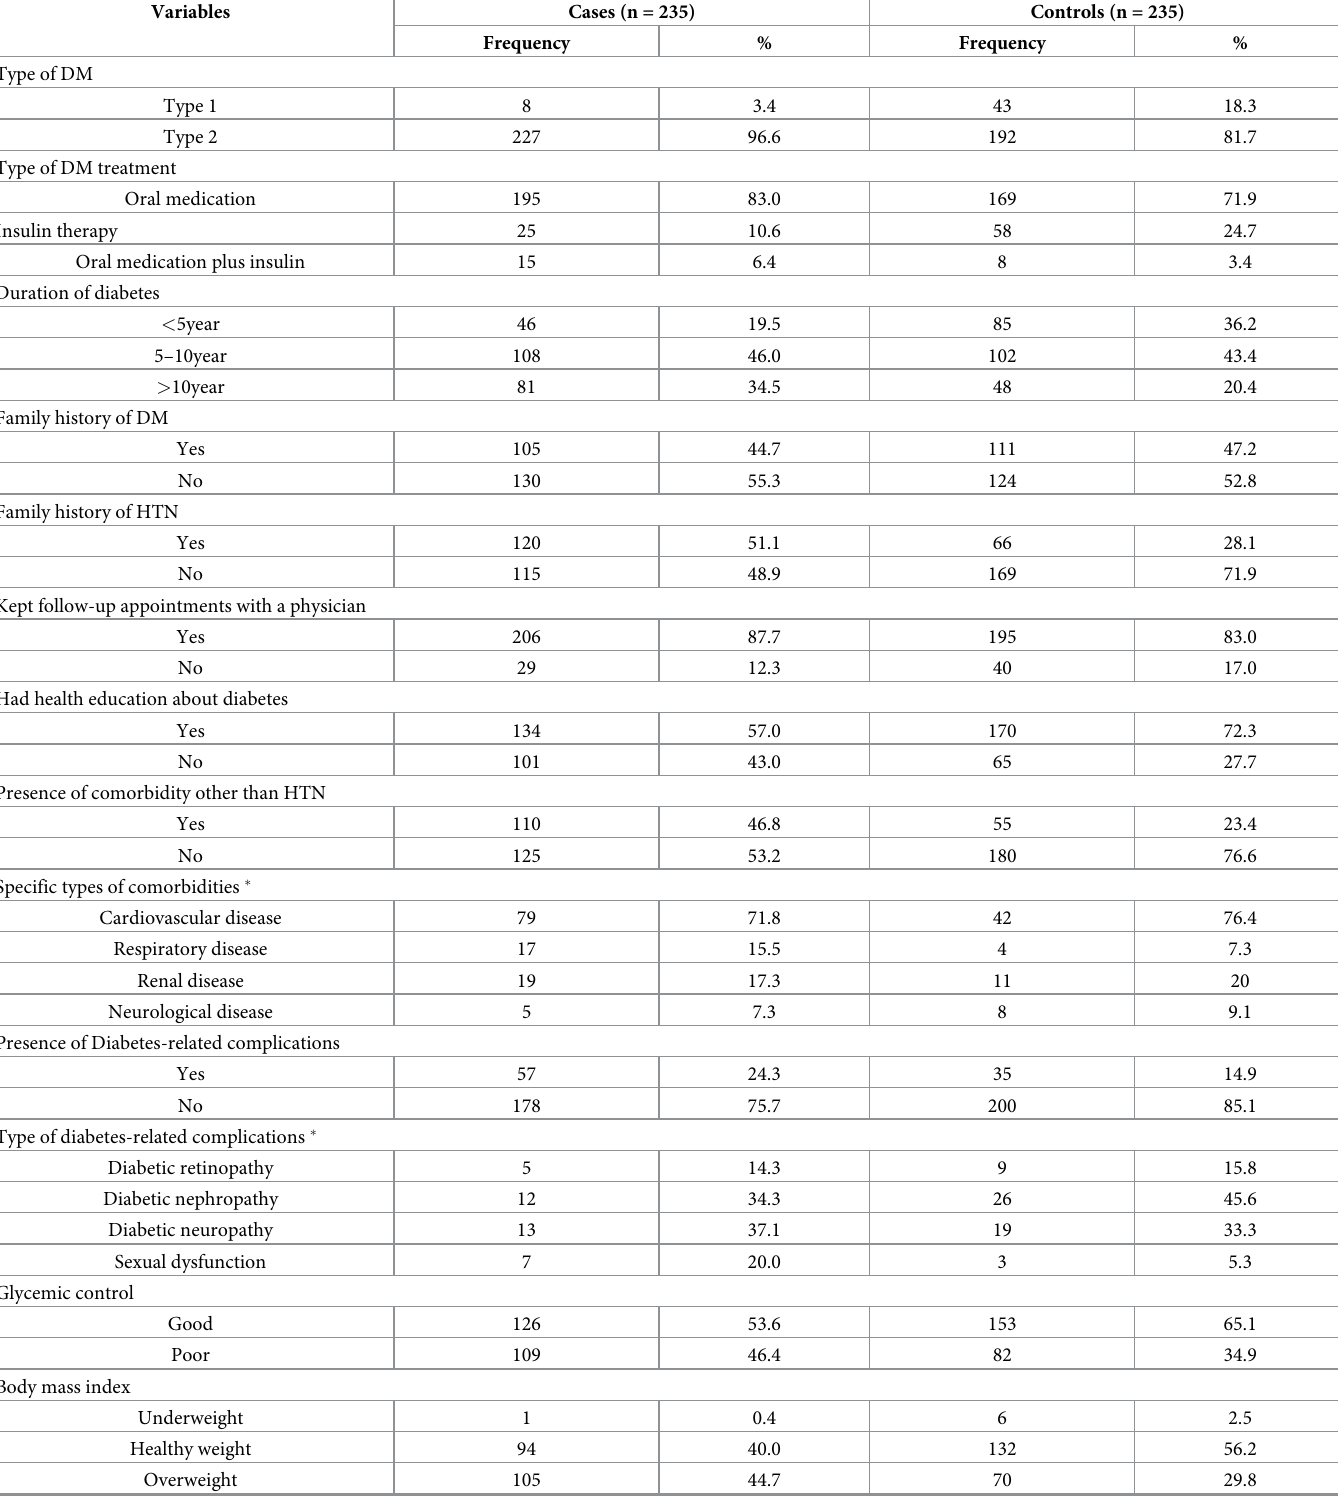
Table 3. Clinical characteristics of study